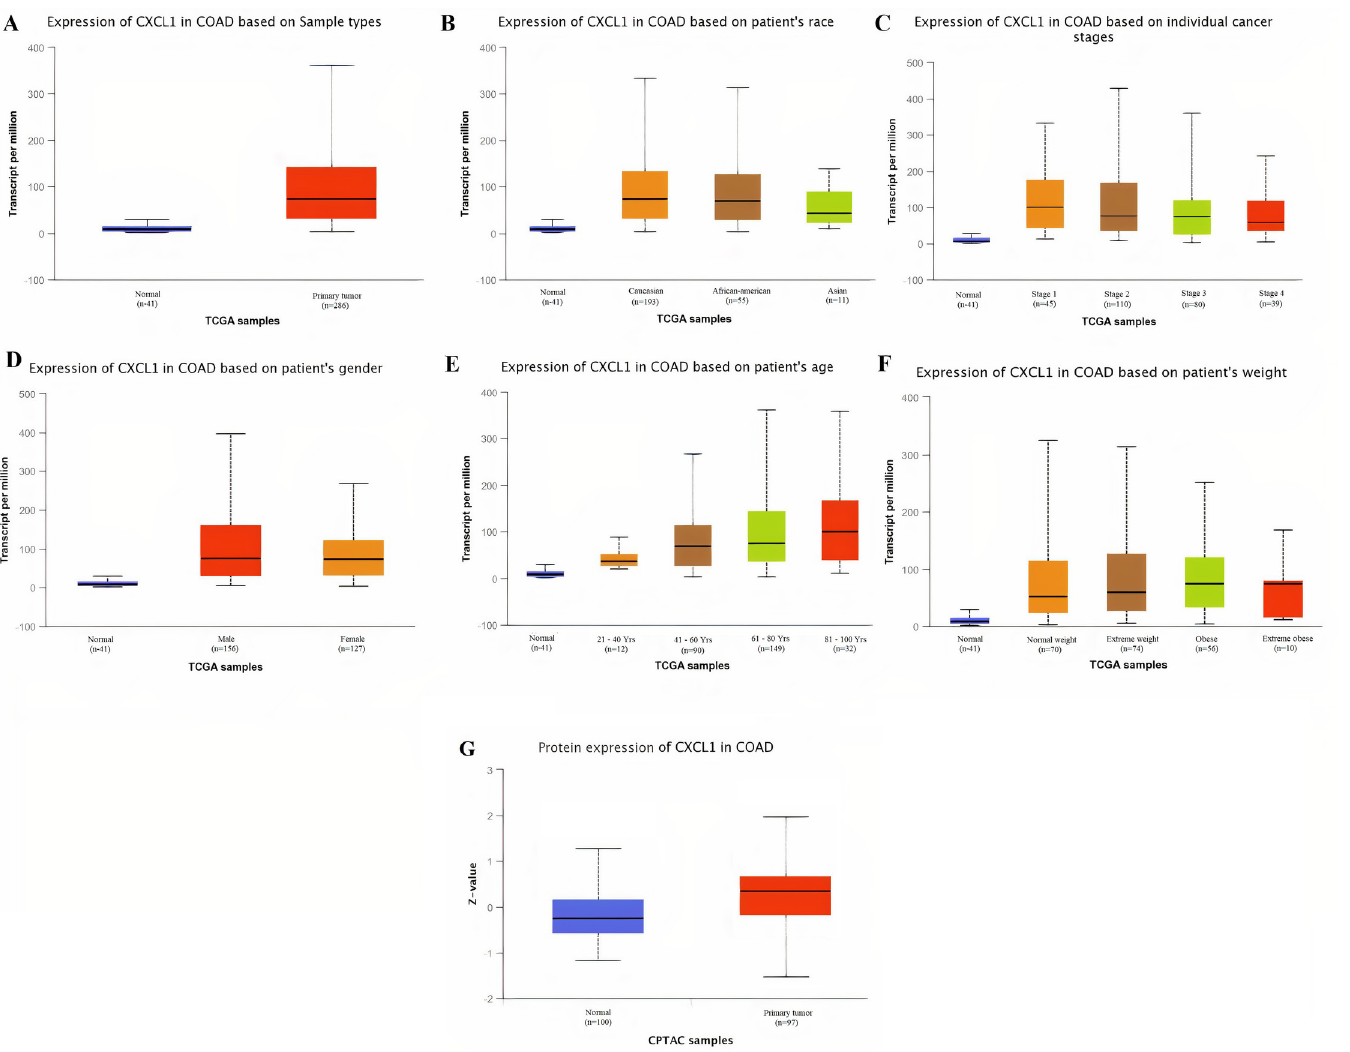
Fig 10. Box plots showing the relative expression levels of CXCL1 in normal and COAD samples of different clinicopathological features via UALCAN database. Relative mRNA expression of CXCL1: (A) in normal individuals and COAD patients; (B) in normal individuals and COAD patients of different races; (C) in normal individuals and COAD patients of different cancer stages; (D) in normal individuals and COAD patients of different genders; (E) in normal individuals and COAD patients of different age groups; and, (F) in normal individuals and COAD patients of different body weights; (G) Relative protein expression of CXCL1 in normal individuals and COAD patients. A p-value of < 0.05 was considered significant. Normal weight = BMI greater than or equal to 18.5 and BMI less than 25, Extereme weight = BMI greater than or equal to 25 and BMI less than 30, Obese = BMI greater than or equal to 30 and BMI less than 40, and Extreme Obese = BMI greater than